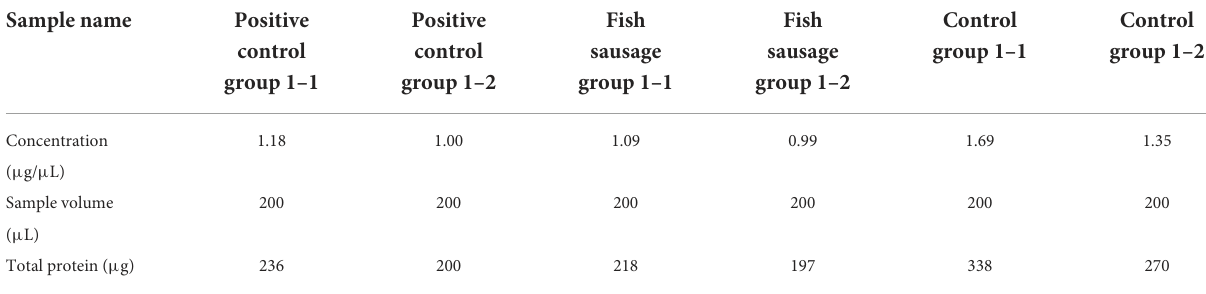
TABLE 4 The quantitative results of protein samples.